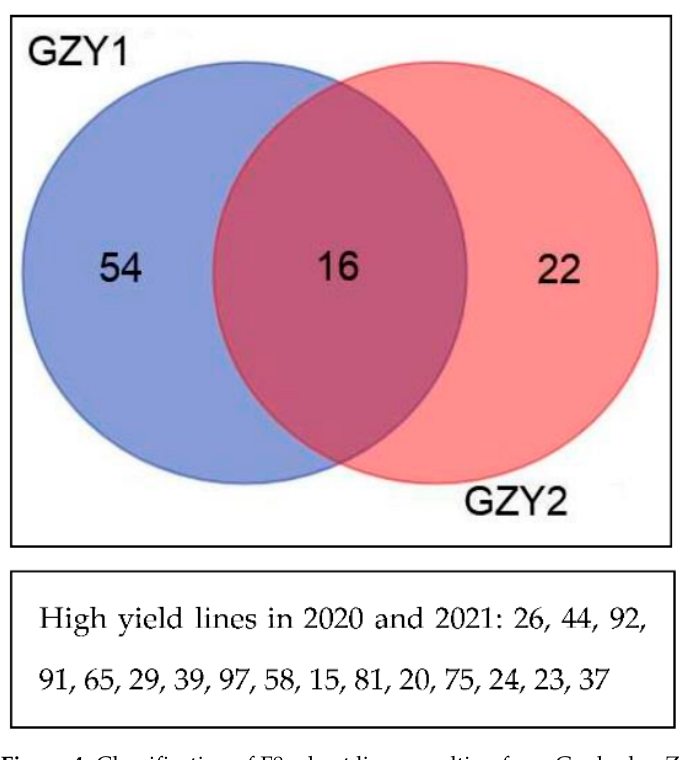
Figure 4. Classification of F8 wheat lines resulting from Gonbad × Zagros in 2020 and 2021. Examining the reaction of lines caused by Gonbad × Zagros crosses by considering significant traits in 2020 using Biplot analysis showed that lines 31, 30, 30, 20, and 26 were the most valuable in terms of PH, NDF, TGW, GYI, and NSP. Considering the traits of PH, NDF, TGW, GYI, and NSP, genotypes 10 and 66 were selected as the best cultivars. NDF and TGW show the most diversity for the examined lines. Moreover, Biplot analysis in 2021 showed that lines 72, 65, 79, 102, and 65 were better in terms of PH, NDF, TGW, GYI, and NSP. Considering these traits, genotype 102 was selected as the best cultivar. The traits of GYI and HI were the most diverse for the studied lines (Figure